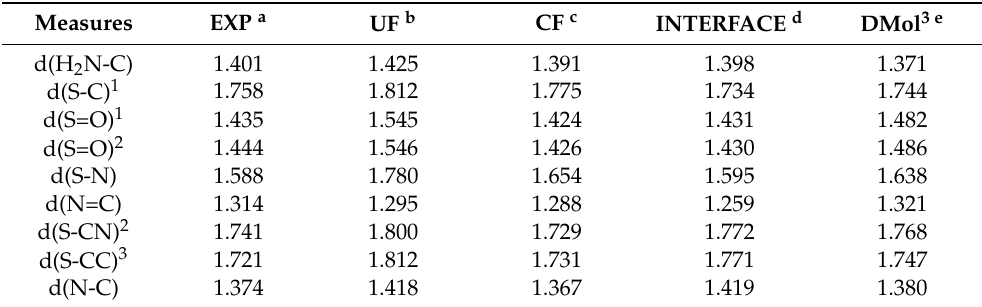
Table 3. Main values of the bond lengths (Å) of the sulfathiazole crystal after optimization with different computational